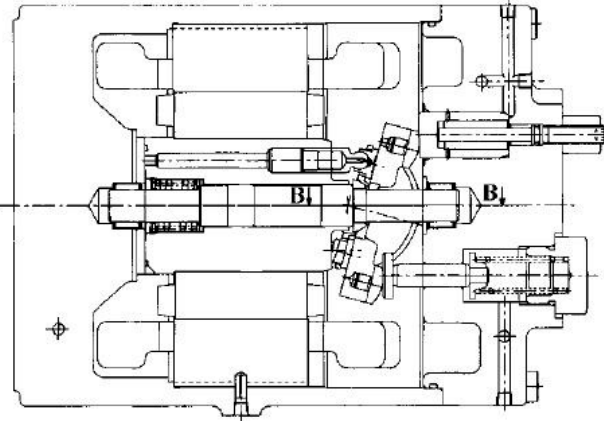
Figure 3. RP series rotary pump of Daikin Company, Osaka, Japan.